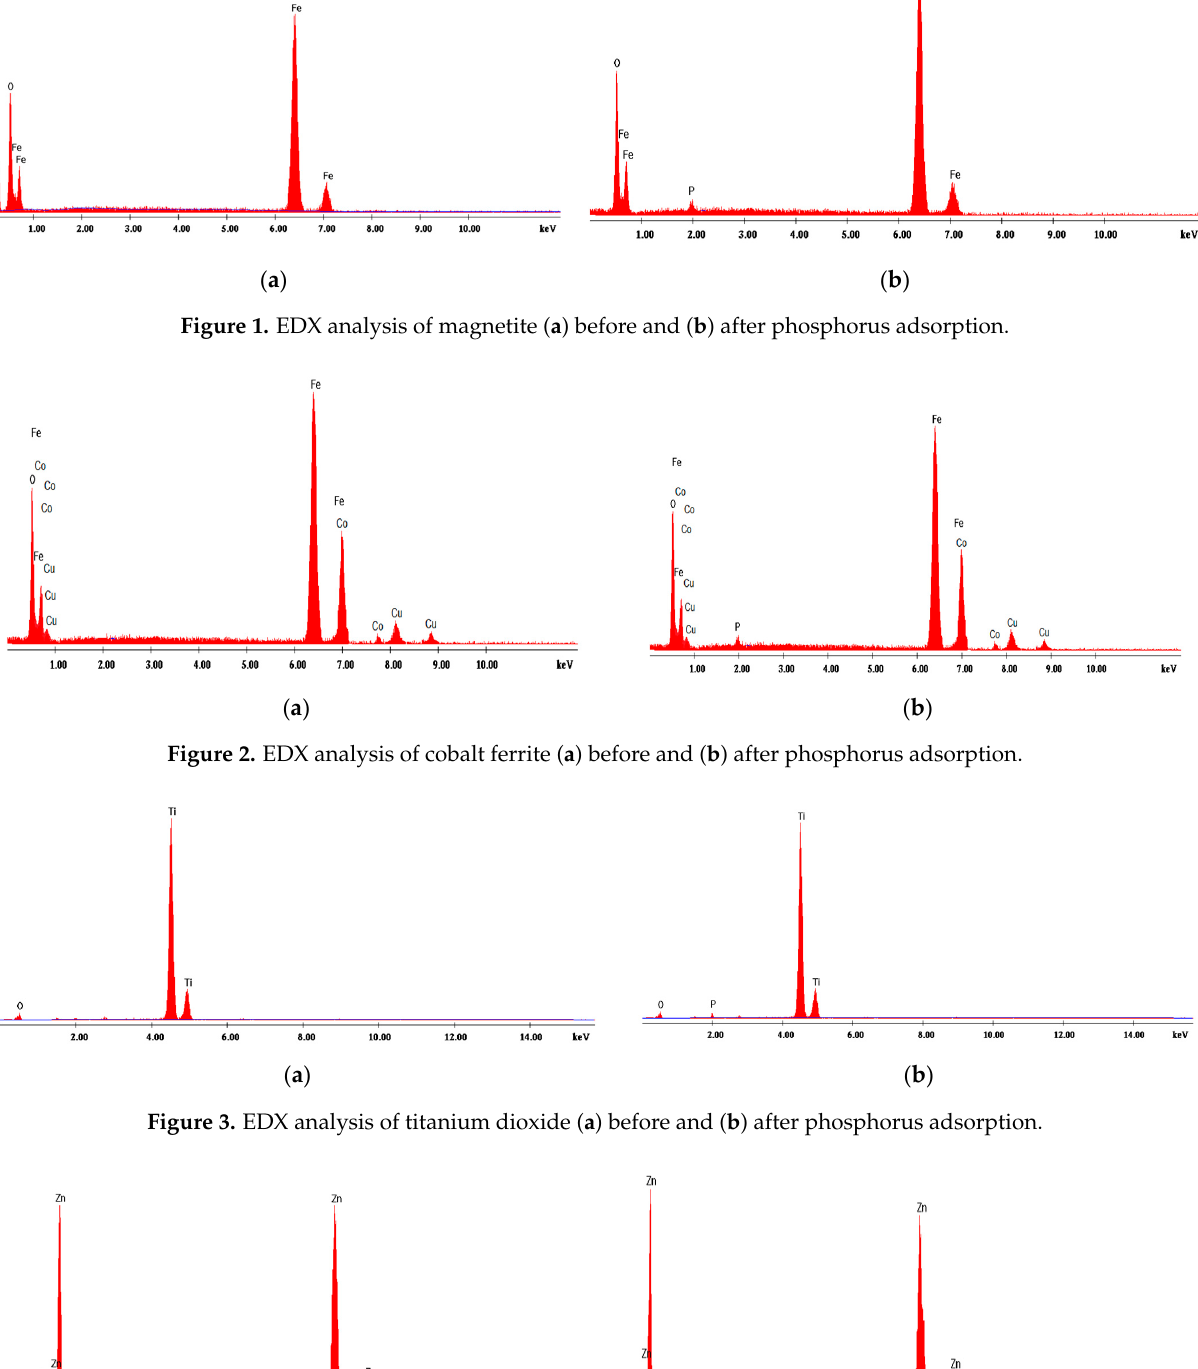
( b ) Figure 5. EDX analysis of zeolite ( a ) before and ( b ) after phosphorus adsorption. Comparative experimental studies have been performed on the conventional (pre- cipitation) and alternative dephosphorization method (adsorption). The chemical precip- itation of phosphorus was performed comparatively by means of two usual reactants in the tertiary stage of wastewater treatment: ferric chloride and aluminum chloride respec- tively. In parallel, the phosphorus removal capacity has been studied on three different types of materials: magnetic (cobalt ferrite, magnetite), semiconductors (zinc oxide, tita- nium dioxide) and composite (zeolite). Two different methods were proposed to determine the phosphorus removal perfor- mance efficiency of these materials: the colorimetric assay method and a chemical micro- analysis technique based on energy dispersive X-ray spectroscopy (EDX). 4.1.3. Investigation Adsorbents Performance through UV-Vis Spectroscopy The colorimetric assay method based on molybdenum blue phosphorus is a sensitive and highly accurate technique [86,98]. The determination of phosphorus was performed by the colorimetric method with ammonium molybdate. Phosphorus reacts with ammo- nium molybdate in the presence of the reducing agent (ascorbic acid solution) to form a blue complex. The blue color intensity of which is directly proportional to the content of phosphorus in final wastewater solutions (after adding coagulants or adsorbents) meas- ured with UV-Vis spectrometer. 4.1.4. Influence of Magnetic Materials on Phosphorus Removal In the next figure (Figure 6), the influence of the conventional method (chemical pre- cipitation with AlCl 3 and FeCl 3 ) versus adsorption on magnetic materials (cobalt ferrite and magnetite) is shown.